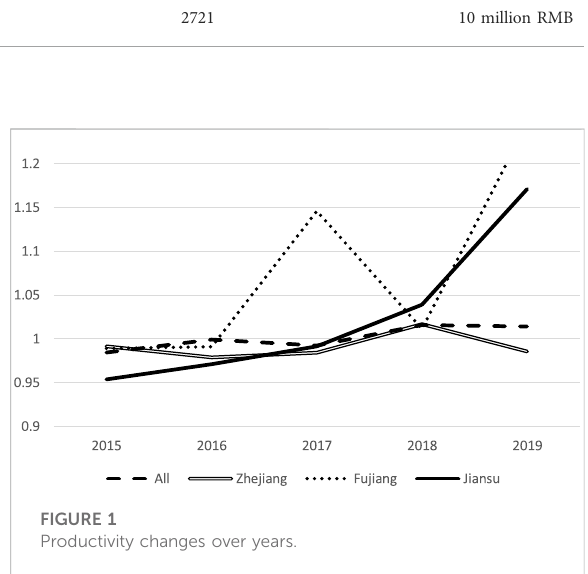
FIGURE 1 Productivity changes over